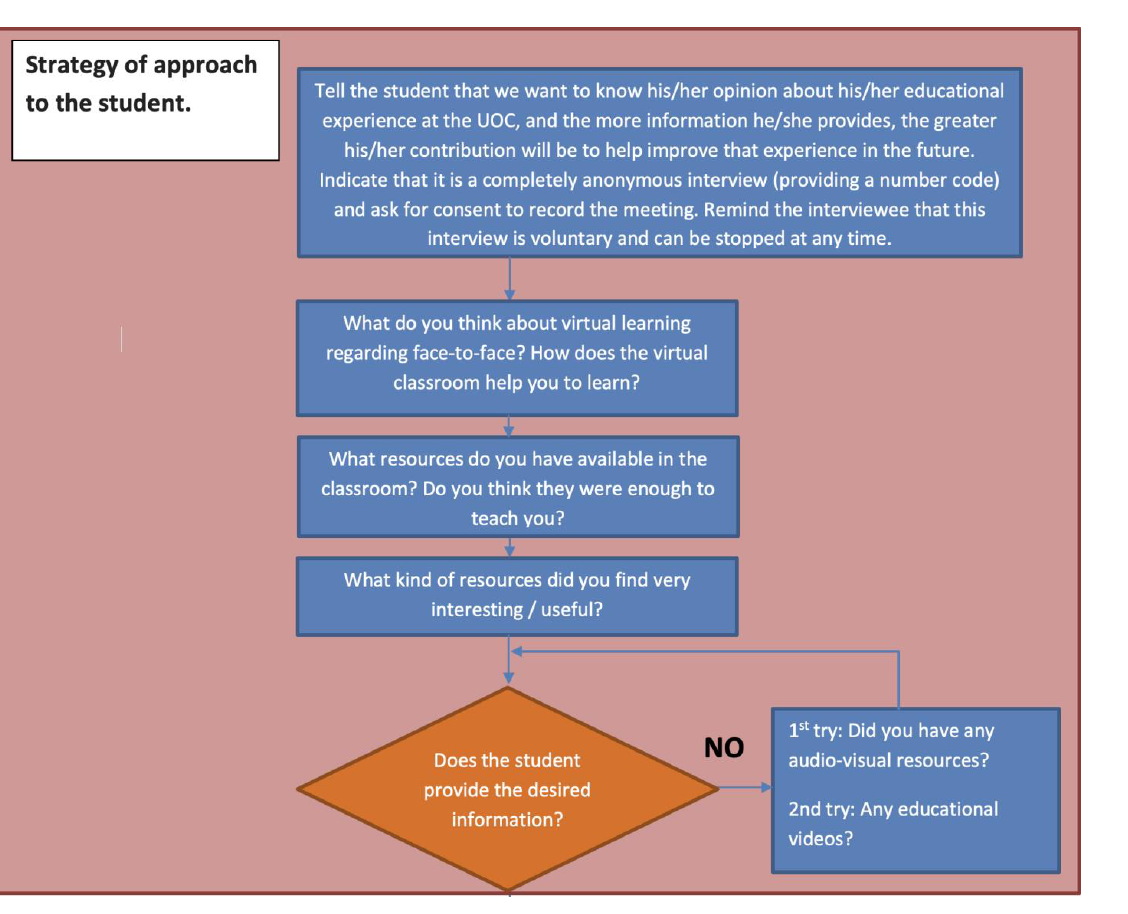
Figure A1. Structure of the interview (I).